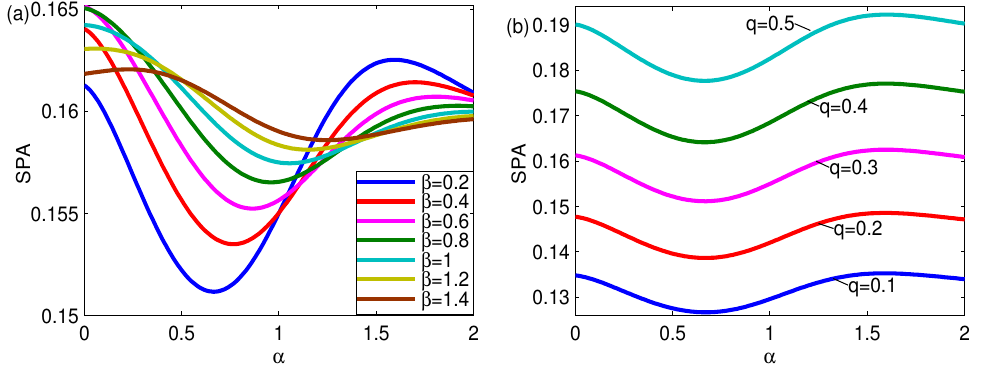
Figure 5. GSR behaviors of SPA( α ) in (35) for different ( a ) β and ( b ) q . ( a ) ¯ γ = 0.1, δ = 1.65, τ = 0.1, a 2 = 0.2, q = 0.3, λ = 0.6, ω 0 = 1, Ω = 2, µ = ν = 0.8; ( b ) β = 0.2, ¯ γ = 0.1, δ = 1.65, τ = 0.1, a 2 = 0.2, λ = 0.6, ω 0 = 1, Ω = 2, µ = ν =